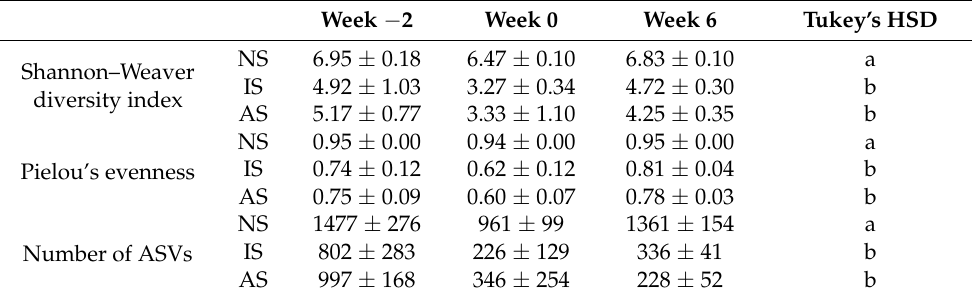
Table 1. Alpha-diversity indices (Shannon–Weaver diversity index, Pielou’s evenness, and amplicon sequence variants (ASVs)) of the soil bacterial communities at different time points (week − 2, 0, and 6). Values represent the mean ± the standard deviation of three replicates. NS, IS, and AS stand for natural soil, inoculated soil, and autoclaved soil. We performed a two-way ANOVA to investigate the interaction between time points and soil treatments on each diversity index, followed by Tukey’s HSD test for pairwise comparisons. No significant interactions between time points and soil treatments were determined for any of the indices. Different letters represent significantly different pairs among soil treatments when averaged across time points ( p <